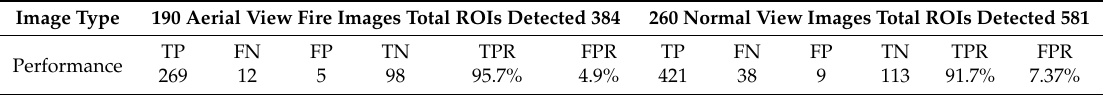
Figure 7. Examples of fire localization and segmentation method on several complex scenes. Table 3. Performance of the proposed localization and segmentation methods.